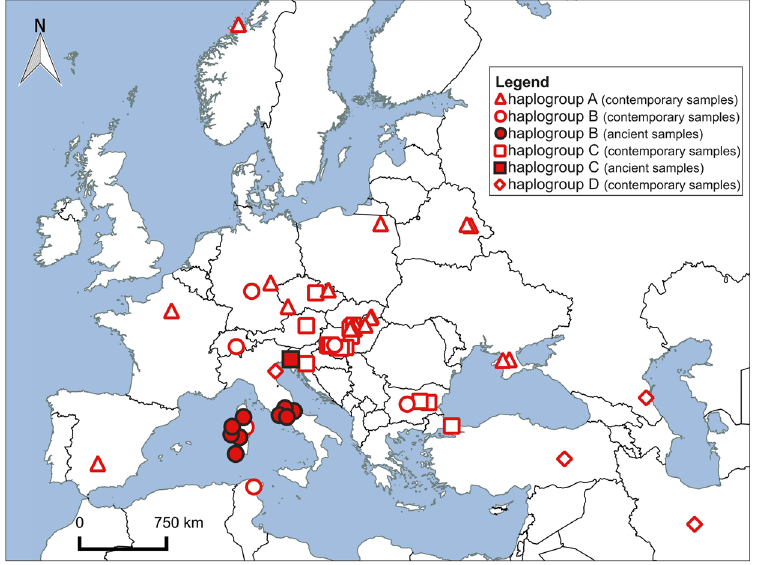
Figure 3. Geographic distribution of mtDNA haplogroups. Haplogroup A is indicated by triangles, haplogroup B by circles, haplogroup C by squares and haplogroup D by diamonds. Red-filled and white-filled signs represent ancient and contemporary samples, respectively. The map was created with the QGIS software 2.18.3 (http://www.qgis.org/pl/site/) based on a source map from the public Natural Earth website (http://www.